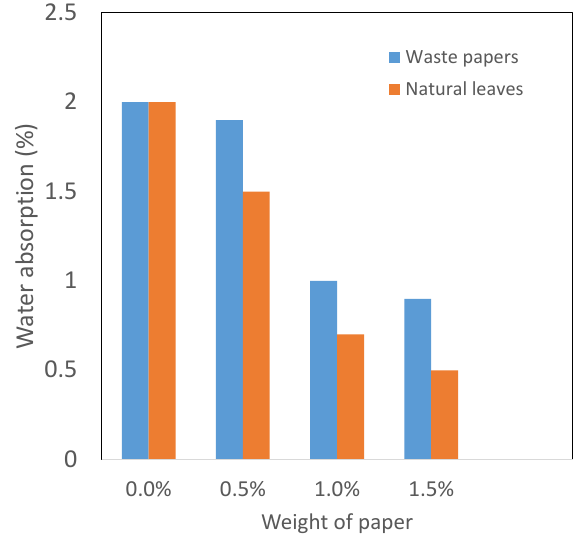
Fig. 10: Water absorption test of the reinforced mortars.